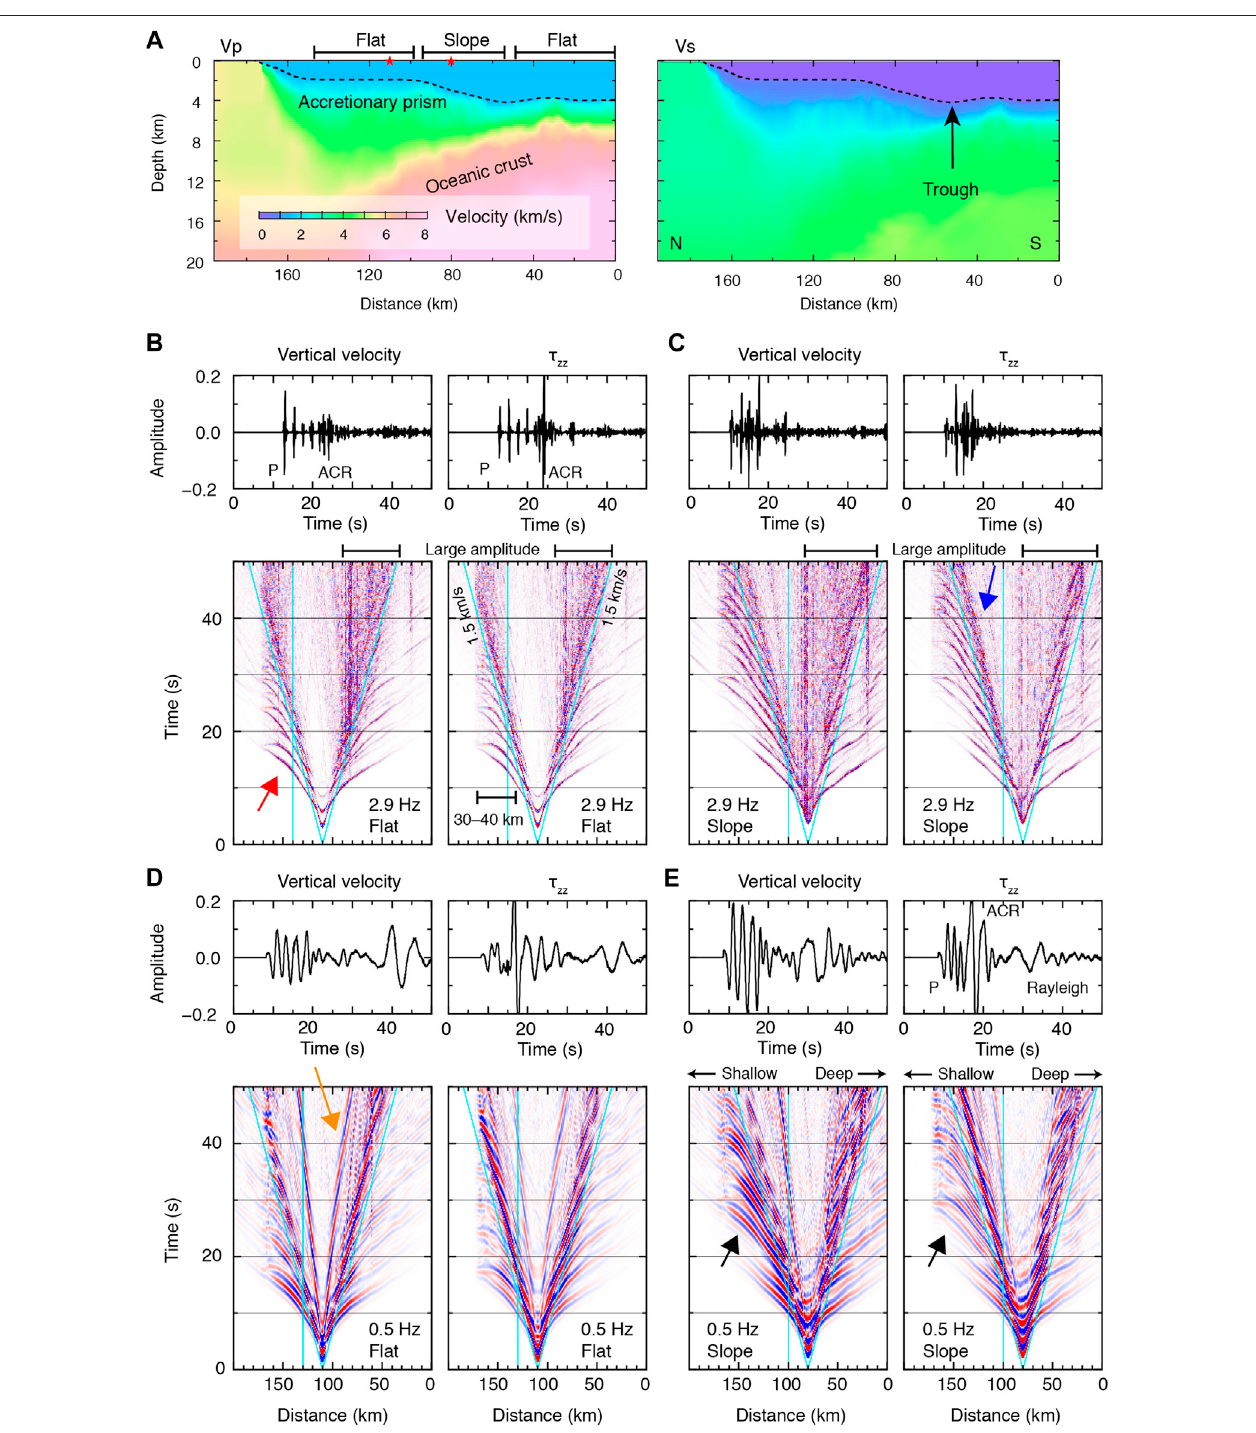
FIGURE 7 | Two-dimensional numerical simulation for wave propagation. (A) Vp model used in the numerical simulation. The dotted line shows the bathymetry. Red stars at 80 and 110 km in horizontal distance show the source locations at the sea surface. (B) Left panels show (top) a waveform example of the vertical velocity observed at 140 km in distance and (bottom) record section. The maximum frequency is 2.9 Hz. The source is located above the fl at bathymetry region. Oblique and vertical light-blue lines represent 1.5 km/s and the waveform that corresponds to the top panel, respectively. The red arrow indicates direct and subsequent P waves. Right panels are the same as left panels, but for τ zz . The amplitudes of the record sections (bottom) are normalized by the maximum amplitude in each record section. (C) Same as (B) , but the source is located above the slope bathymetry region. The blue arrow indicates the ACR wave propagation. (D) Same as (A) , but the maximum frequency is 0.5 Hz. The orange arrow represents the Rayleigh wave propagation. (E) Same as (C) , but the maximum frequency is 0.5 Hz. The black arrows indicate the asymmetric radiation pattern of P wave amplitudes.